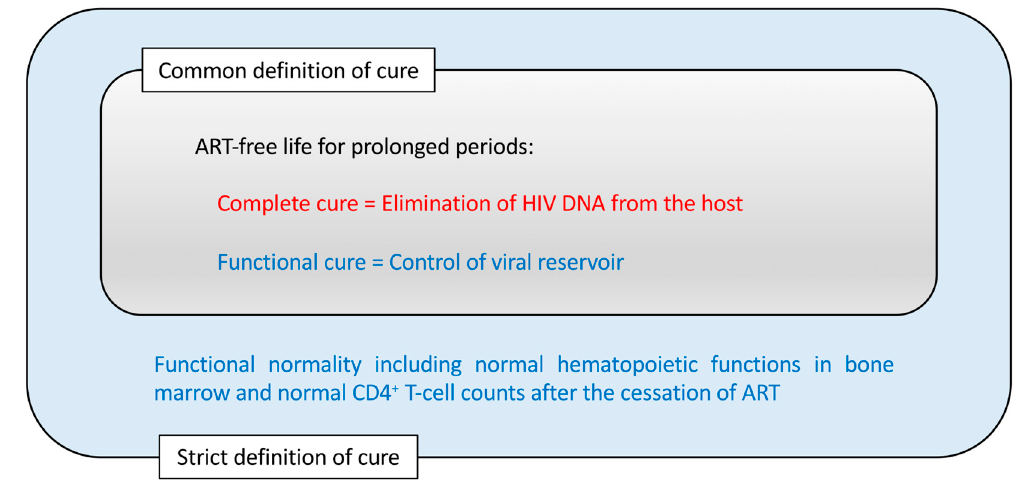
Figure 1. The concepts of human immunodeficiency virus (HIV) cure. A cure for the HIV disease is commonly interpreted as antiretroviral drug therapy (ART)-free life without viral rebound for prolonged periods. In addition, the cure for bone marrow dysfunctionalities observed in HIV-infected patients could be included in a stricter definition of a HIV cure.